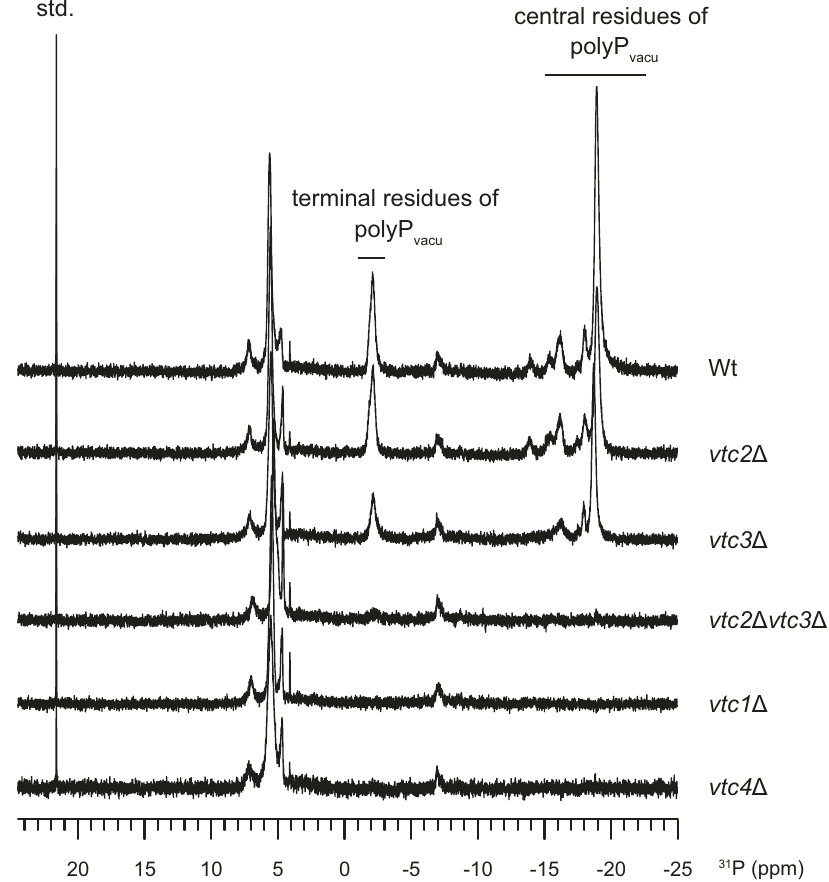
Fig. 1 | In-cell 31 P-NMR measurements of vacuolar polyP in yeast strains. Che- mical shifts of the terminal and central residues of vacuolar polyP are indi- cated, respectively. MDP was used as the std. reference. Wt indicates the